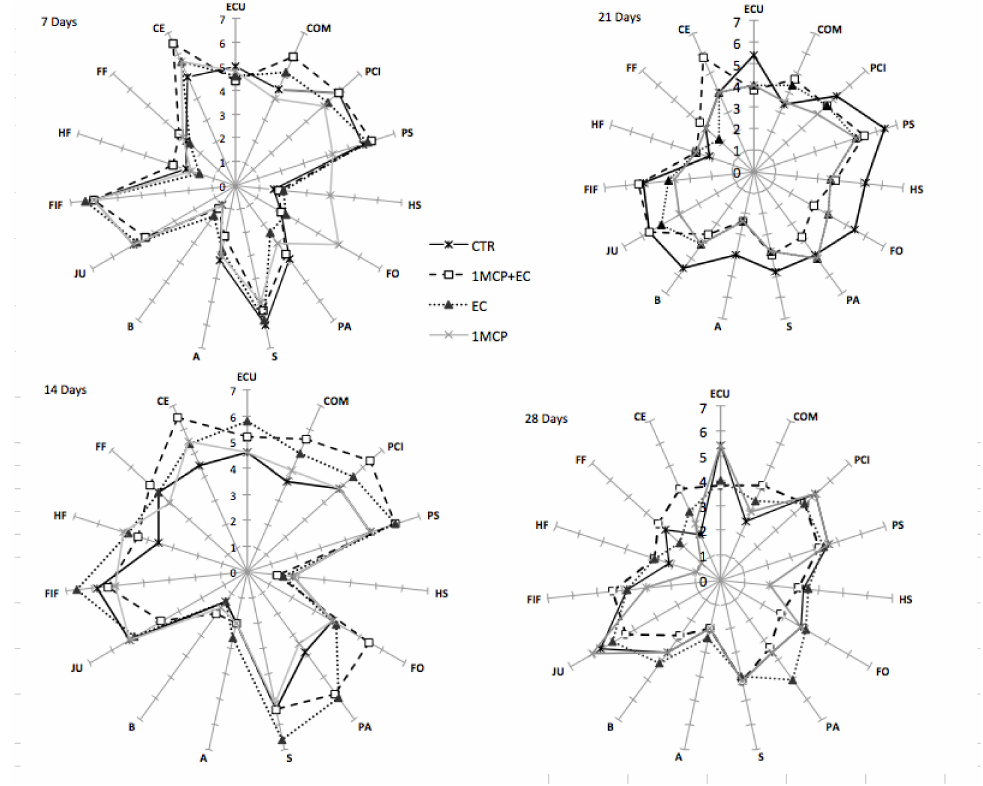
Figure 8. Evolution of scores for the sensory analysis in white flesh melting peaches ( P. persica ) cv Settembrina treated with the edible coating (EC) and 1-MCP + EC, 1-MCP, and untreated (CTR) after shelf life at 20 ◦ C. n = 15 for each stage and treatment. Descriptors: External color uniformity ( ECU ); compactness ( COM ); pulp color intensity ( PCI ); peach smell ( PS ); herbaceous smell ( HS ); floral